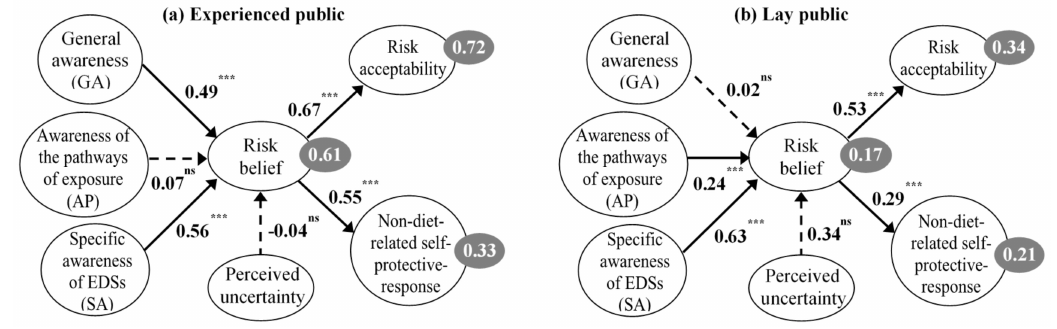
Figure 4. Contribution of three levels of knowledge on the risk belief of the experienced public ( a ) and the lay public ( b ). *** p < 0.001; ns